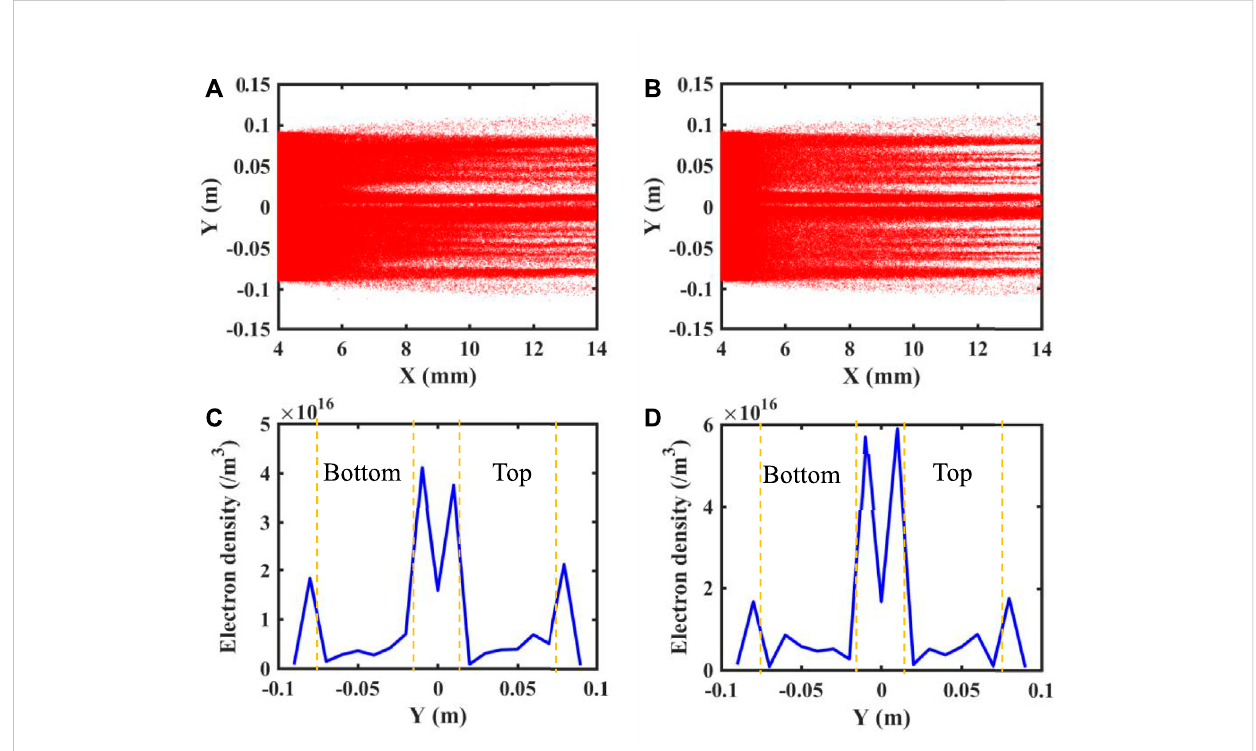
FIGURE 12 (A) . The spatial distribution diagram of electrons in the X-Y direction before the magnetic fi eld optimization; (B) . The spatial distribution diagram of electronsintheX-Ydirectionafterthemagnetic fi eldoptimization; (C) .Theelectrondensitydistributioninthe Y directionnear1 mmofthePGbeforethe optimization; (D) . The electron density distribution in the Y direction near 1 mm of the PG after the